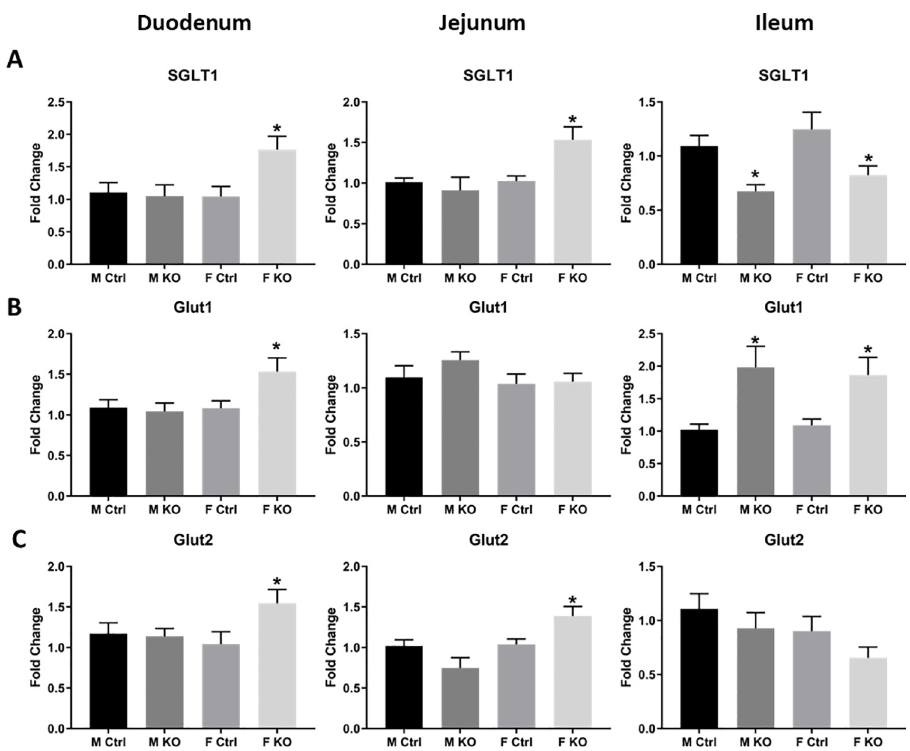
Fig 6. Glucose transporters SGLT1, Glut1, and Glut2 change expression due to intestinal epithelial specific loss of Slfn3, intestinal region, and sex. Total RNA was isolated from intestinal mucosa of the duodenum, jejunum, and ileum of control (Ctrl) and VC-Slfn3KO (KO) mice. The mRNA expression of (A) SGLT1, (B) Glut1, and (C) Glut2 was analyzed by qPCR using RPLP0 as a reference control gene. (n = 9–41, � p < 0.05 to respective